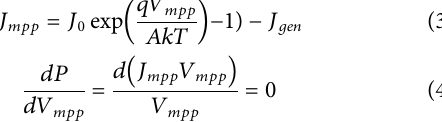
Frontiers in Physics |